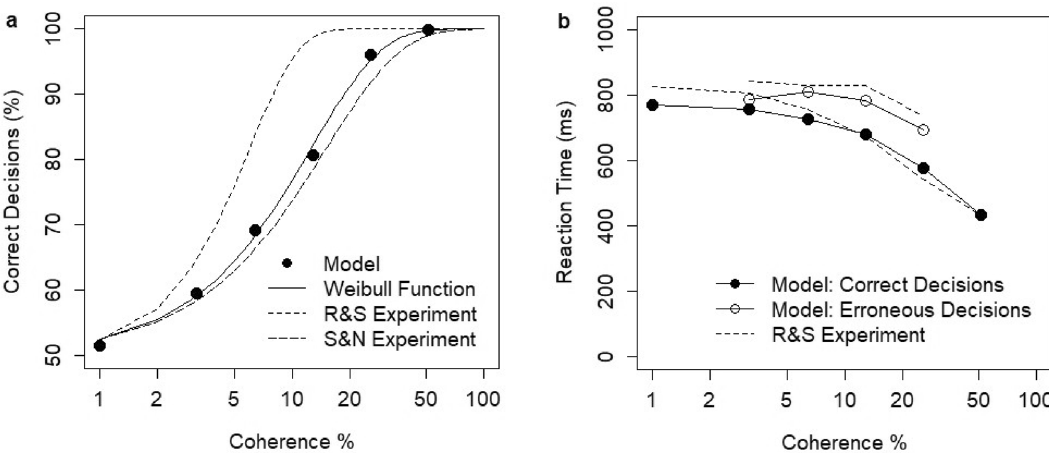
Figure 10. Model predictions for the dot motion discrimination task. ( a ) Psychometric function: N = 12,000 model runs (2000 per coherence level c = 0, 3.2, 6.4, 12.8, 25.6, and 51.2%), SEM: 0.09–1.14; dotted lines: approximation of the experimental data of Shadlen and Newsome (S&N) 8 and Roitman and Shadlen (R&S) 9 with the Weibull function; solid line: approximation of model estimates: α = 12.5 and β = 1.18. ( b ) Reaction time (RT) as a function of correct and erroneous decisions and coherence level, SEM: 2.5–45.3; dotted lines: experimental data of Roitman and Shadlen (R&S) 9 , the weighted average from two monkeys. Shadlen and Newsome 8 used the working-memory (fixed duration) paradigm only, and hence RT was not